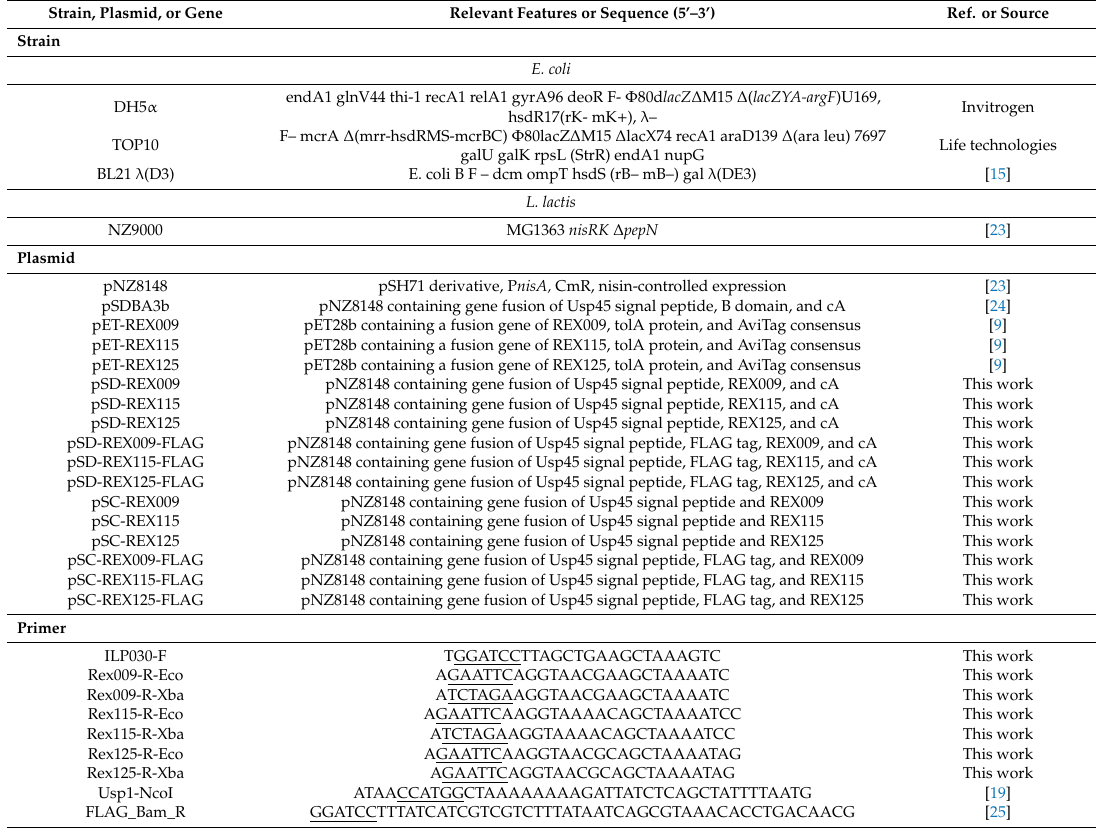
Table 1. Strains, plasmids, and primers used in the study. Restriction recognition sites are underlined. Strain, Plasmid, or Gene Relevant Features or Sequence (5’–3’) Ref. or